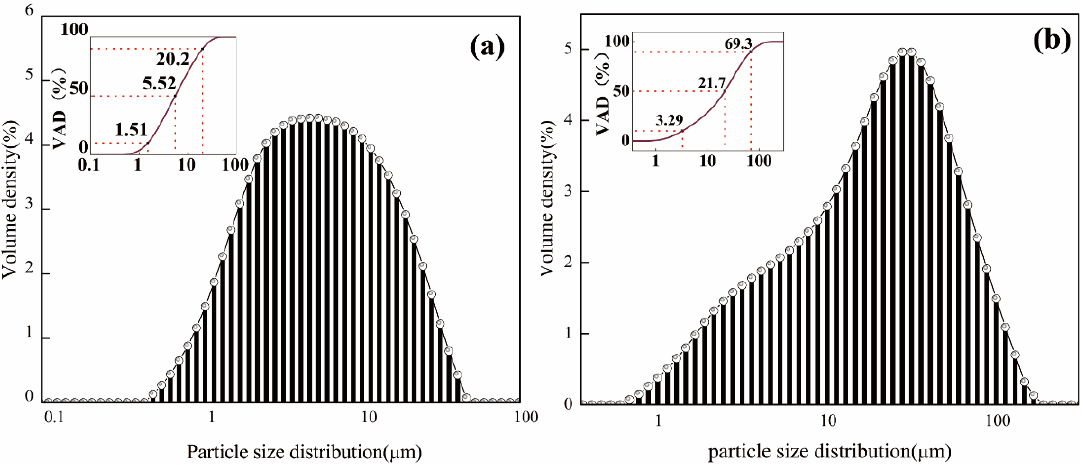
Figure 1. Laser particle size analysis of ( a ) BFS and ( b ) FGDG.